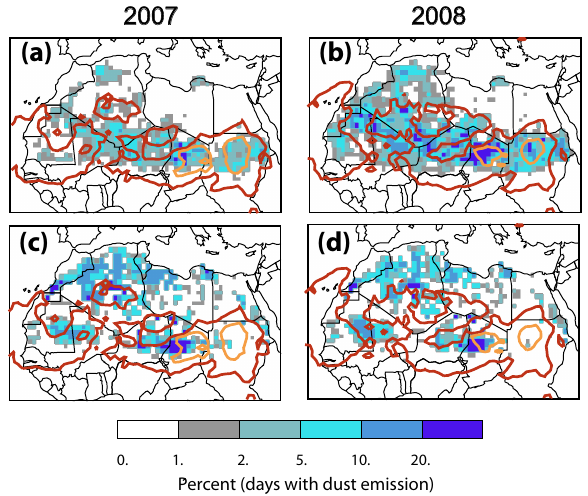
0. Percent (days with dust emission) Fig. 3. Percent of days per month with dust emission derived from the MSG SEVIRI IR dust index (a, b) and simulated with the COSMO-MUSCAT model (c, d) ; for year 2007 (left) and 2008 (right). The red and orange contours indicate areas where the oc- currence of low level jets in the model is higher than 15 and 30 percent of the days per year,